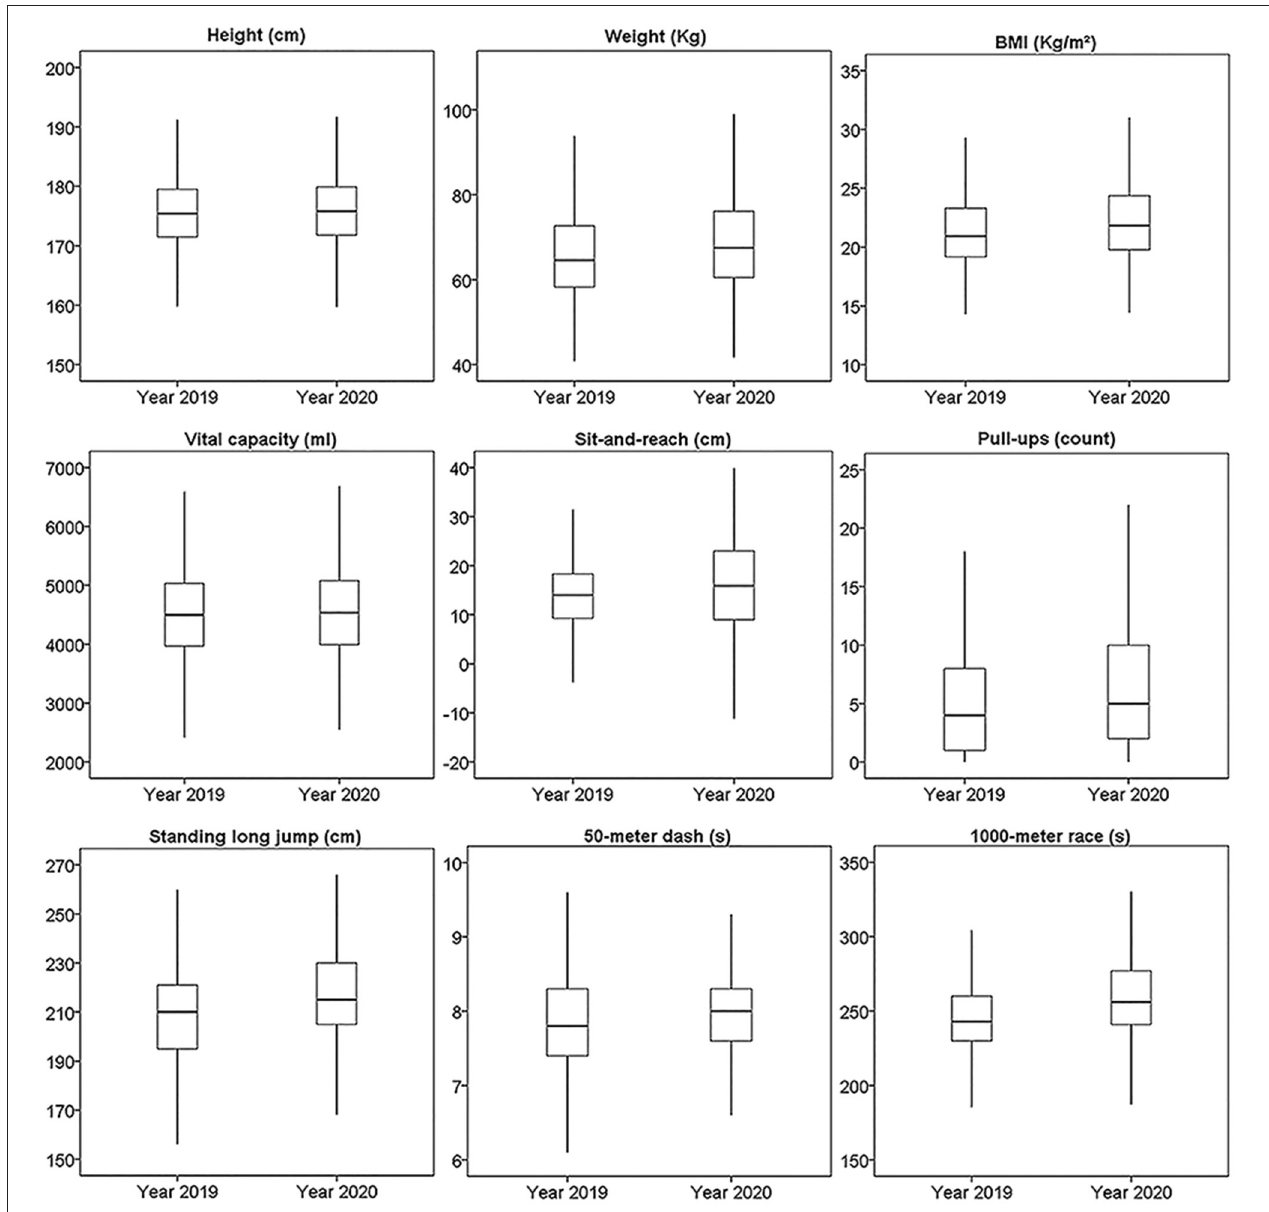
FIGURE 2 | The boxplots of nine results of physical fitness tests from 24,112 male records. Middle line in the box represents the median. The upper and lower boundaries of the box represent upper and lower quartiles. The endpoints of whiskers represent upper and lower